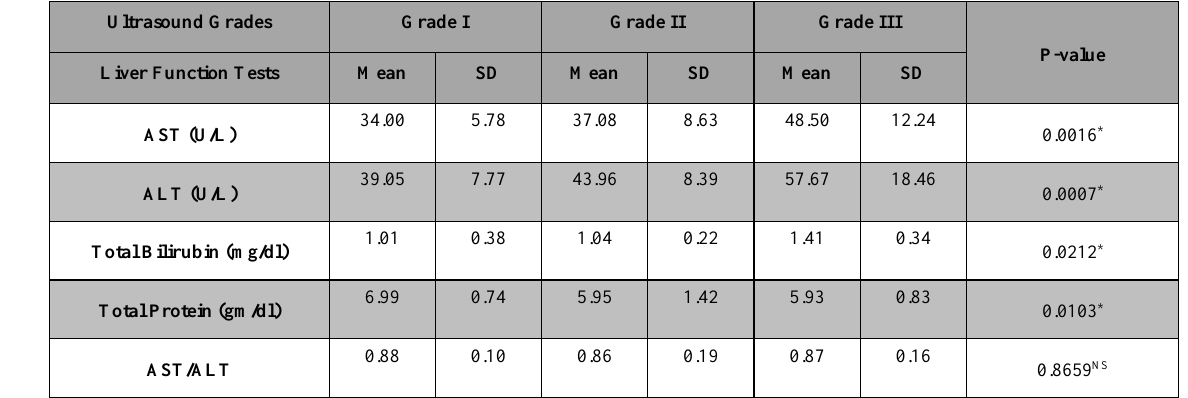
Table 5. Comparison of liver function tests between different grades of